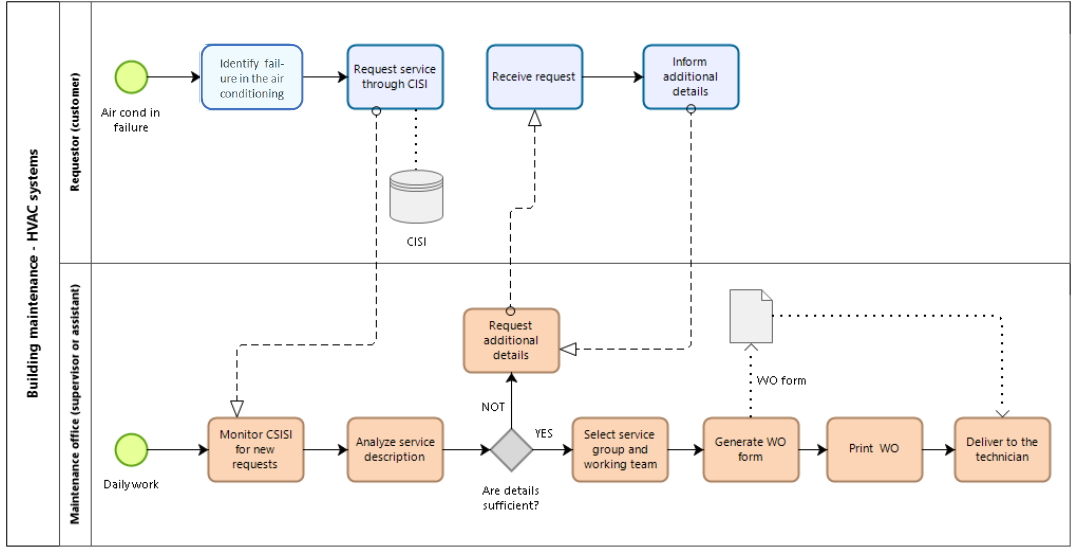
Figure 4. Work orders (WOs) issuance in BPMN.